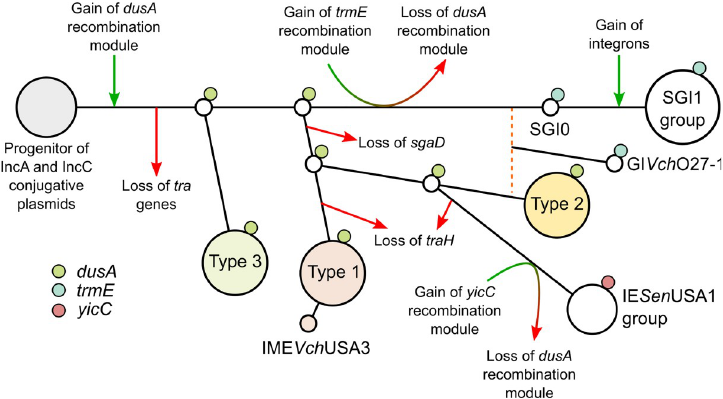
Fig 7. Proposed hypothetical evolutionary pathway of SGI1-like IEs. The sequence of events was inferred from the phylogenetic trees presented in this study, site of integration and conservation of traH and sgaD in the IEs. The proposed pathway ignores the gene cargo and presumes that the IE lineages evolved from the progenitor of IncA and IncC plasmids. The dusA -specific recombination module was chosen as the progenitor to minimize gain/loss and recombination events. Green and red arrows indicate gene gains and losses, respectively. The orange dashed line indicates a probable recombination event from which stemmed GI Vch